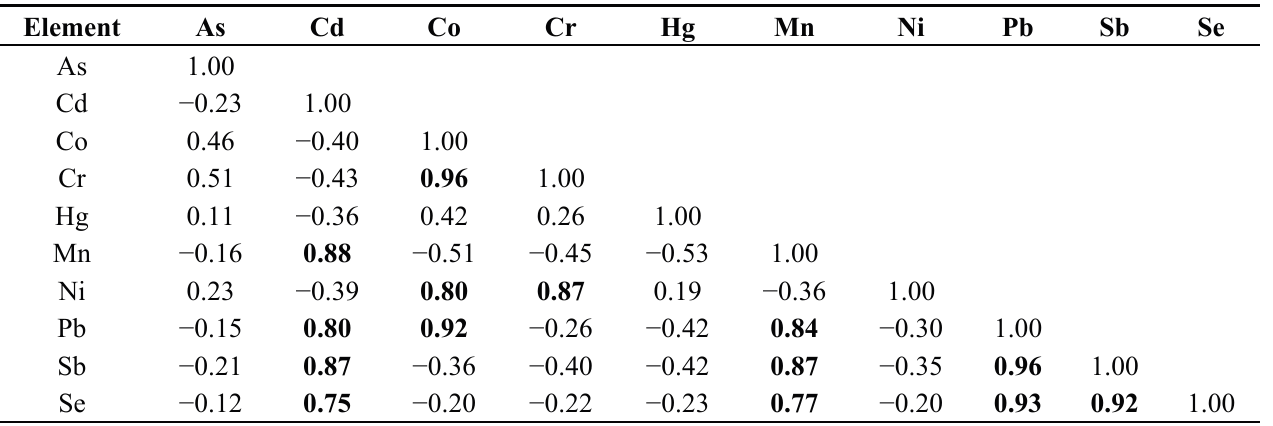
Table 4. Correlation coefficients between the different trace elements for Fraction 3 collected in the surroundings of four power plants.